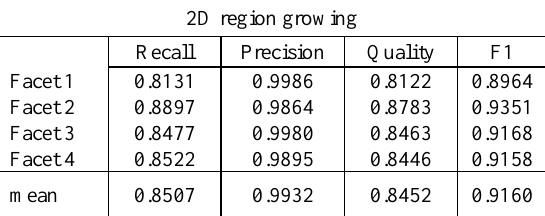
Table 1 . Evaluation metrics for 2D region growing method.